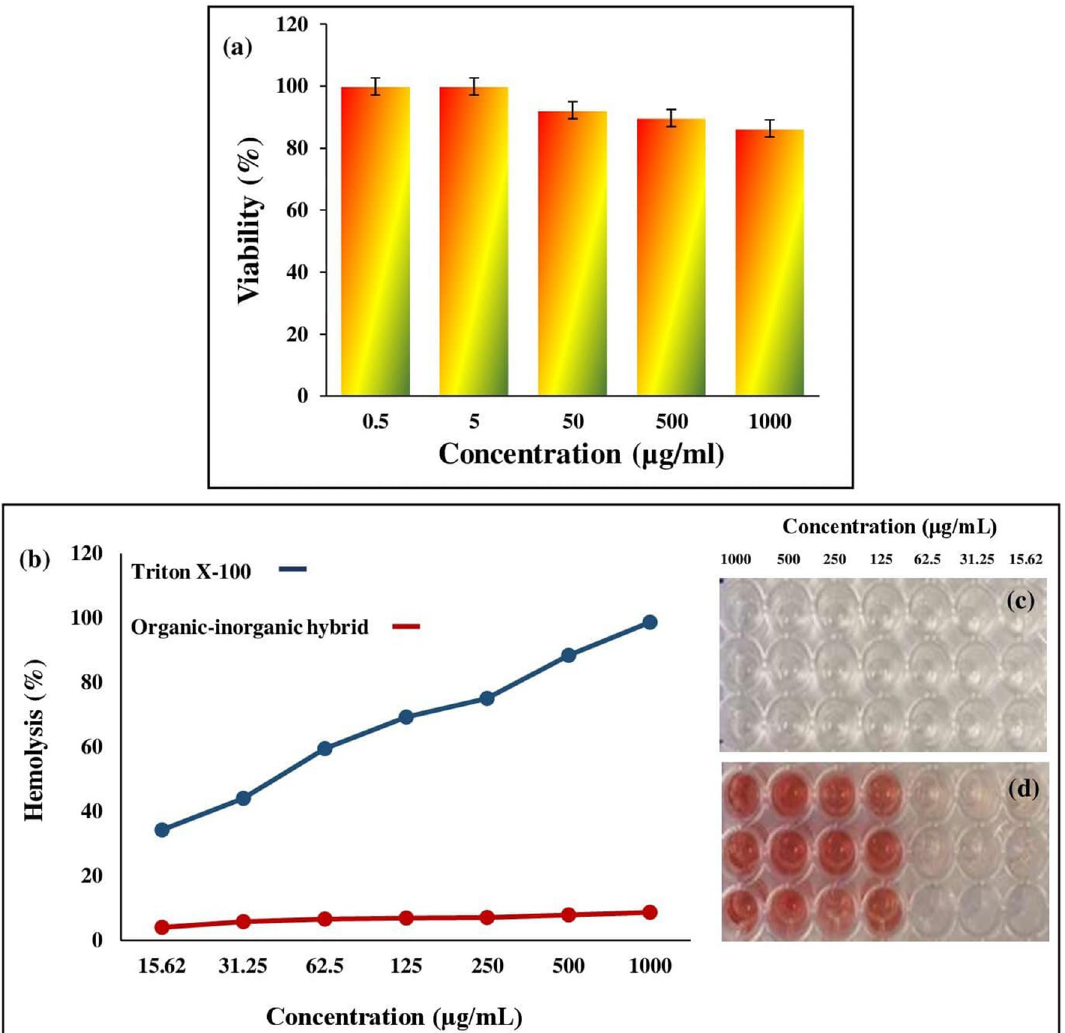
Figure 8. ( a ) Hu02 cell viability percentage at different concentrations of synthesized hybrid. ( b ) Hemolysis percentage graph of synthesized hybrid and Triton X-100 (positive control) at different concentrations; comes with 96-well plate image from: synthesized hybrid ( c ) and Triton X-100 ( d ) at different concentrateons.